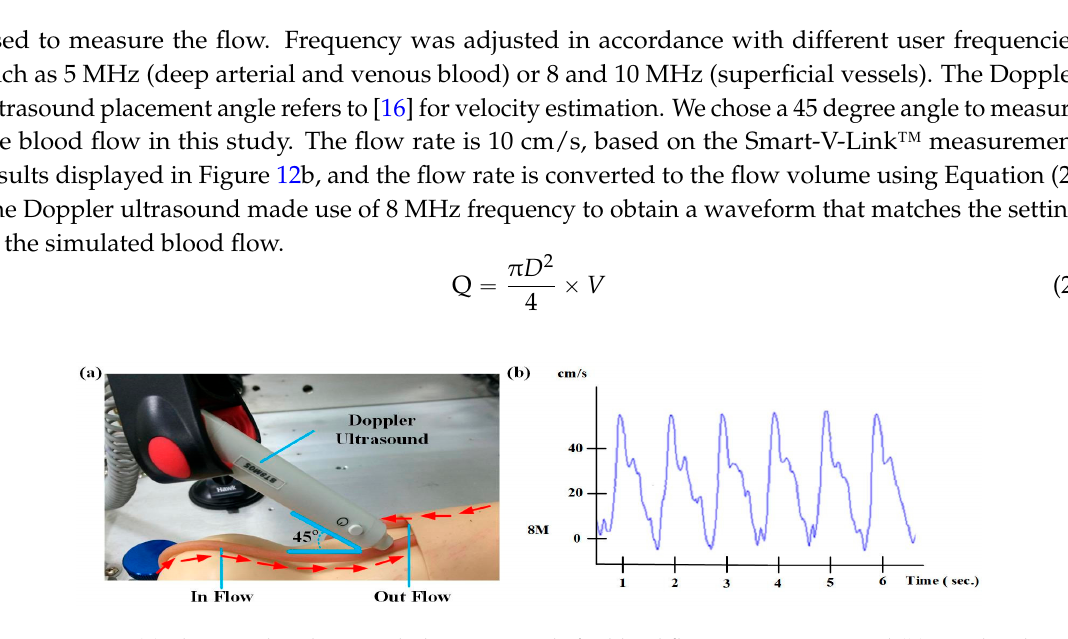
Figure 12. ( a ) The Doppler ultrasound placement angle for blood flow measurement and ( b ) simulated blood flow waveform.